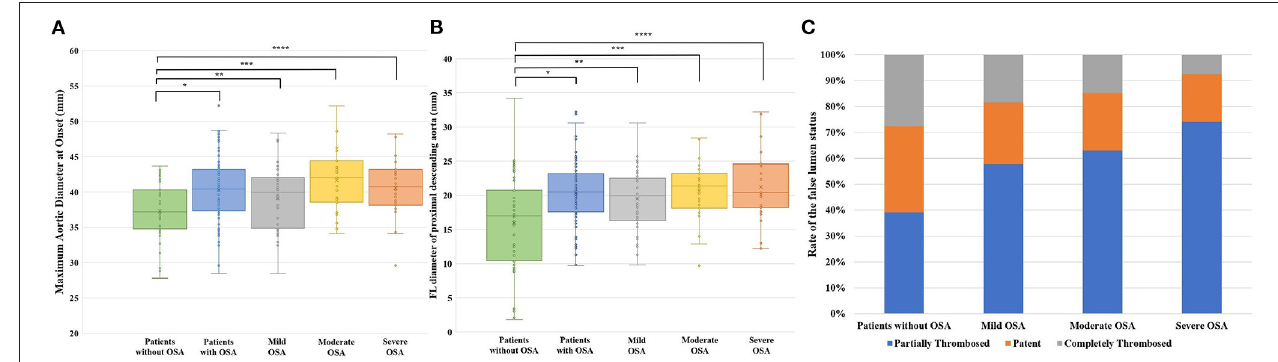
FIGURE 2 | Imaging signs related to LAEs in different OSA severities. (A) Aortic diameter at onset for different degrees of OSA severity. * p < 0.001; ** p = 0.044; *** p < 0.001; **** p = 0.001. (B) FL diameter of the proximal descending thoracic aorta for different OSA severities. * p < 0.001; ** p = 0.004; *** p < 0.001; **** p < 0.001. (C) Rate of the FL status in different OSA severities.